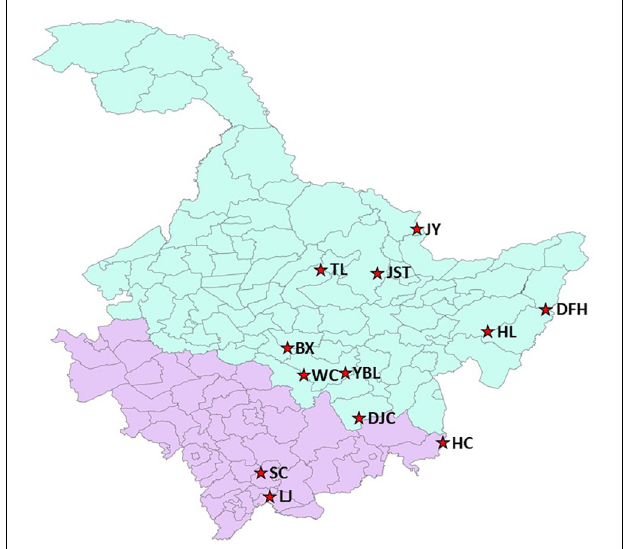
FIGURE 1 | Geographic locations of 12 J. mandshurica populations in this study. Light blue indicates Heilongjiang Province and light purple indicates Jilin Province. The geographic conditions for each site can be found in Supplementary Table 1 . BX, Binxian, HLJ; DFH, Raohe, HLJ; DJC, Ning’an, HLJ; HC, Hunchun, JL; HL, Hulin, HLJ; JST, Yichun, HLJ; JY, Jiayin, HLJ; LJ, Linjiang, JL; SC, Baishan, JL; TL, Tieli, HLJ; WC, Wuchang, HLJ; YBL,